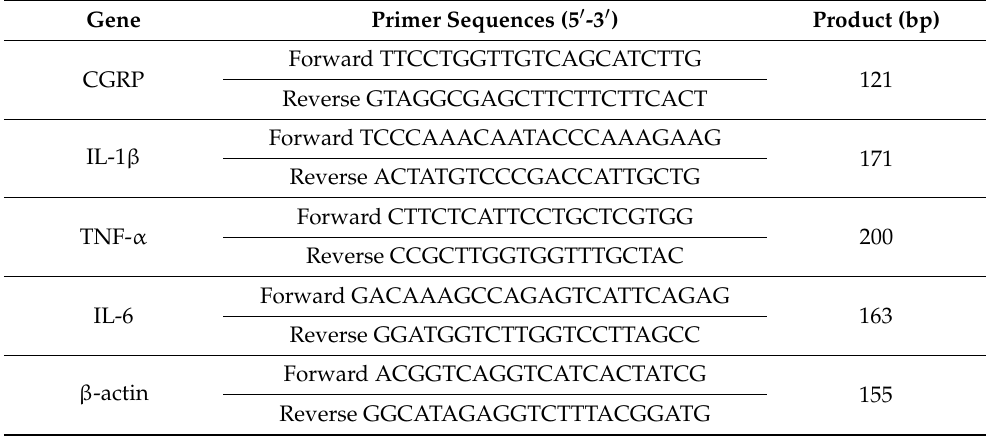
Table 1. Sequences and Product Length of Primers used.